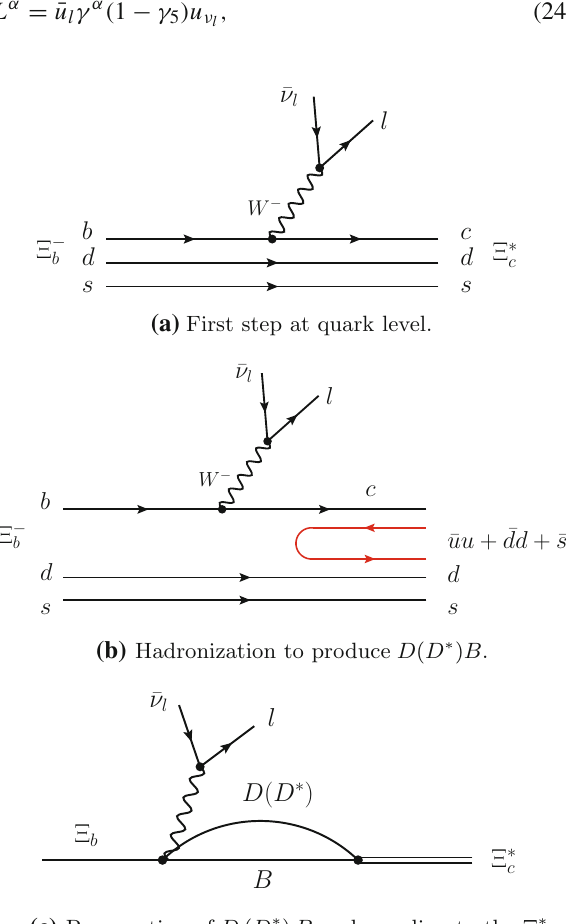
Fig. 4 Different steps of (cid:2) ∗ c production in the (cid:2) b → ¯ ν l l (cid:2) ∗ c